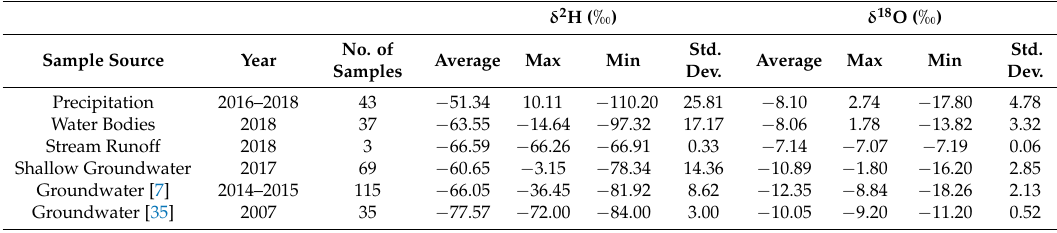
Table 1. Summary of collected water samples and stable isotope.